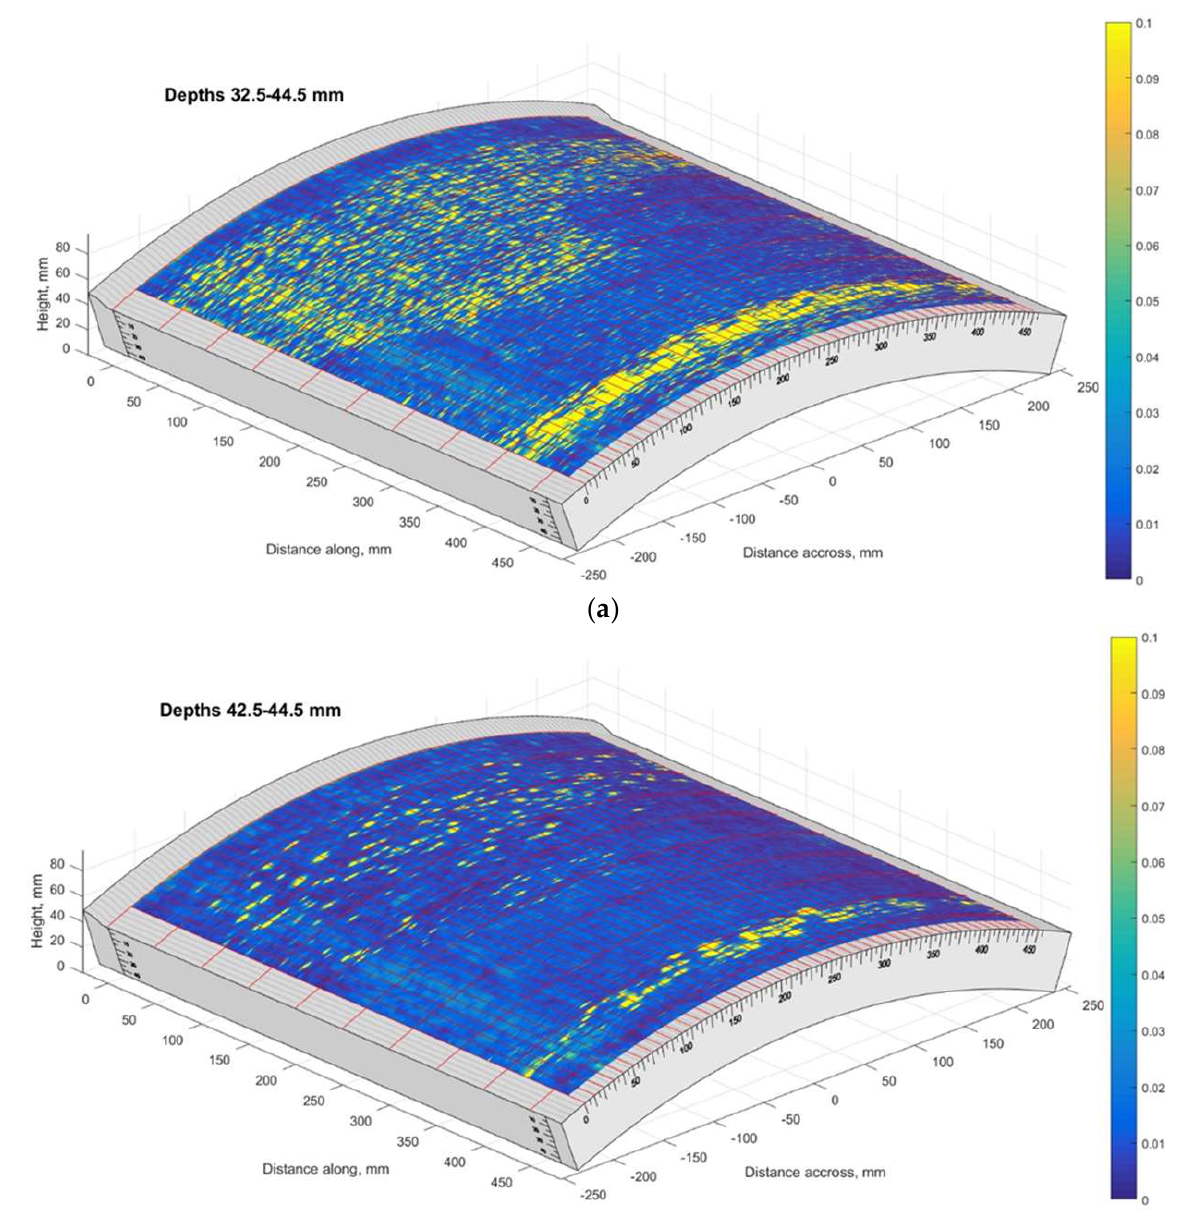
Figure 4. The TFM scan of the Sample No. 4: ( a ) depth range of 32.5–44.5 mm; ( b ) depth range of 42.5–44.5 mm. Vertical colour bar represents the peak-to-peak amplitude in arbitrary units.